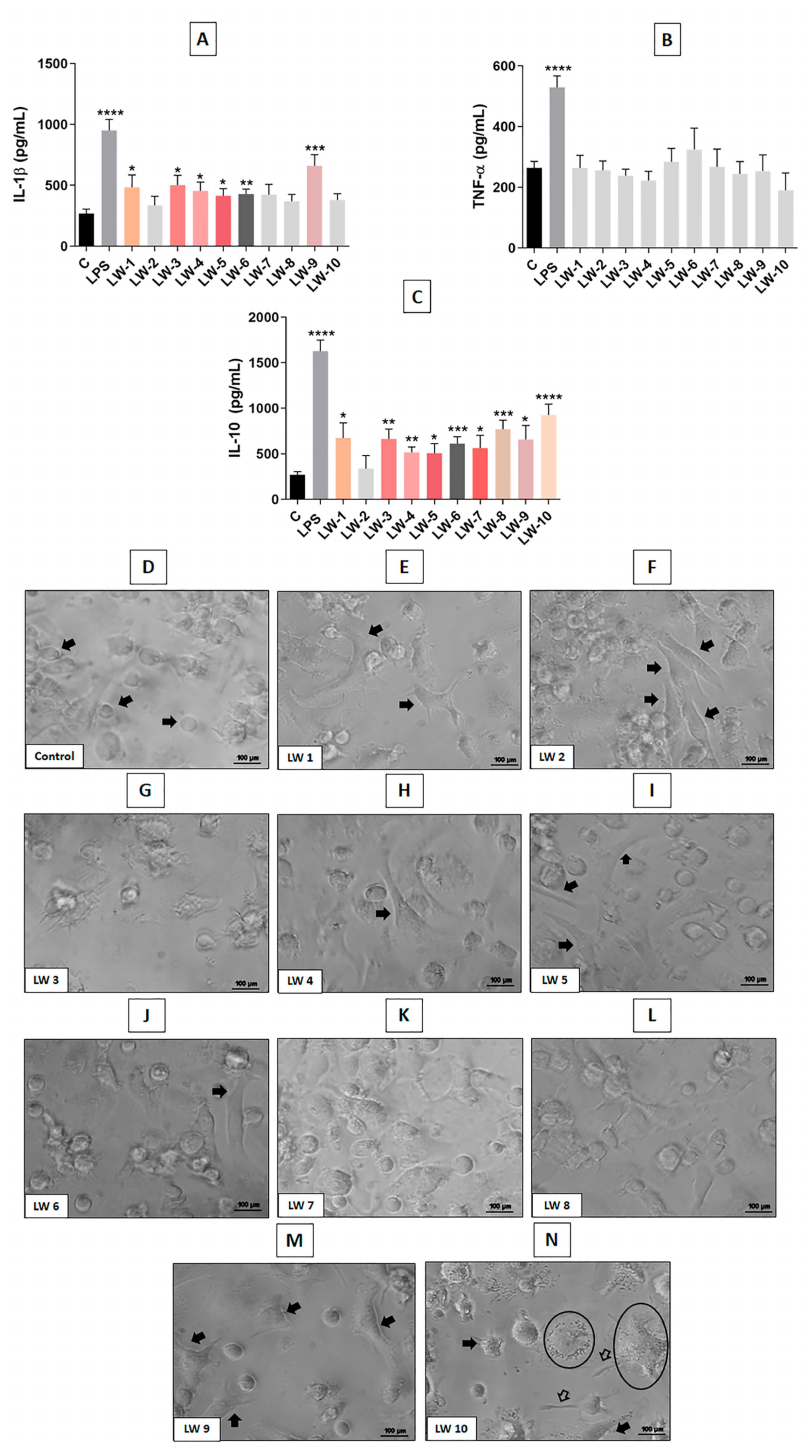
Figure 7. Cytokines release and morphology of DCs stimulated with purified subfractions. Graphs ( A – C ) show the production of pro-(IL-1 β , TNF- α ) and anti-inflammatory (IL-10) cytokines by DCs treated with purified subfractions (1 µ g/mL) for 24 h, by ELISA. Panels D–N show morphological changes observed in DCs after treatments ( D – N ). Signs in panels indicate morphological changes compared to the untreated control (panel ( D )). Arrows: irregular bodies and processes; circled cells: granular cytoplasm. Eclipse Ts2 Diascopic (Nikon Inc.); Bars = 100 µ m. Data were analyzed by one-way ANOVA and Kruskal–Wallis test, presented as mean ± standard error (SEM). Unpaired Student’s t -test was used to compare each treatment with the control. * p < 0.05, ** p < 0.01, *** p < 0.001, **** p < 0.0001 compared to the untreated control. Results of three independent